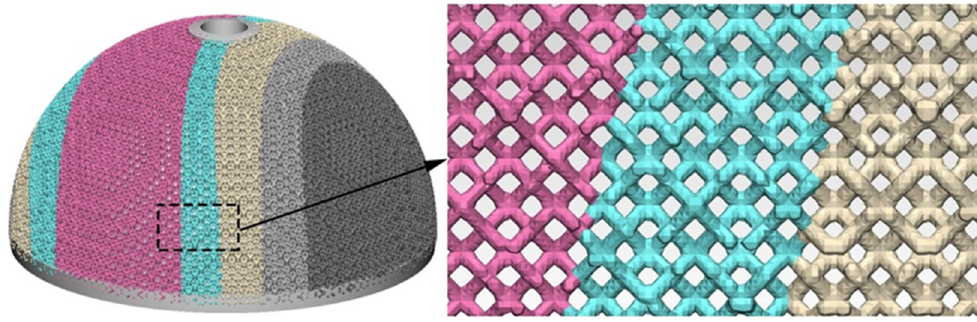
Figure 12. Trabecular acetabular cup model.